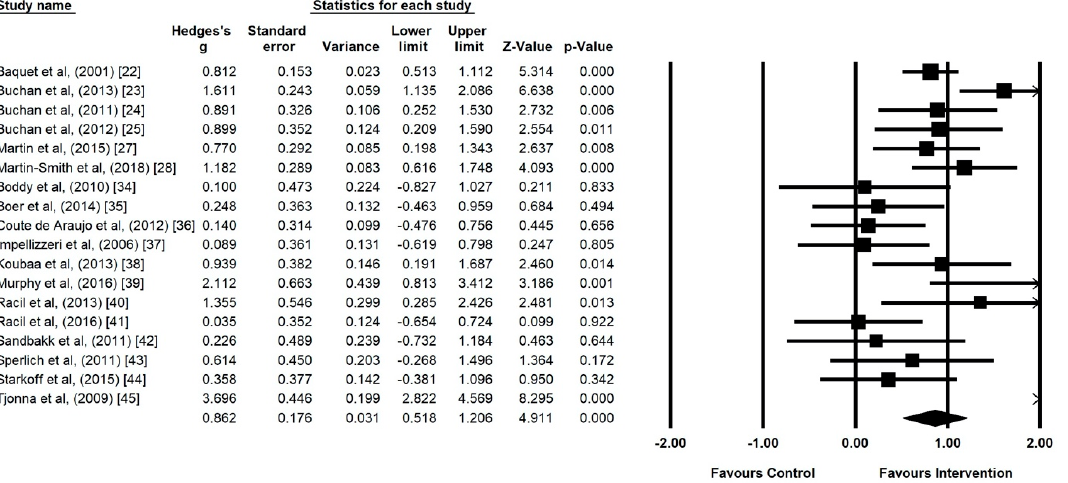
Figure 3. Forest plot of high intensity interval training (HIIT) versus control using random effects model.